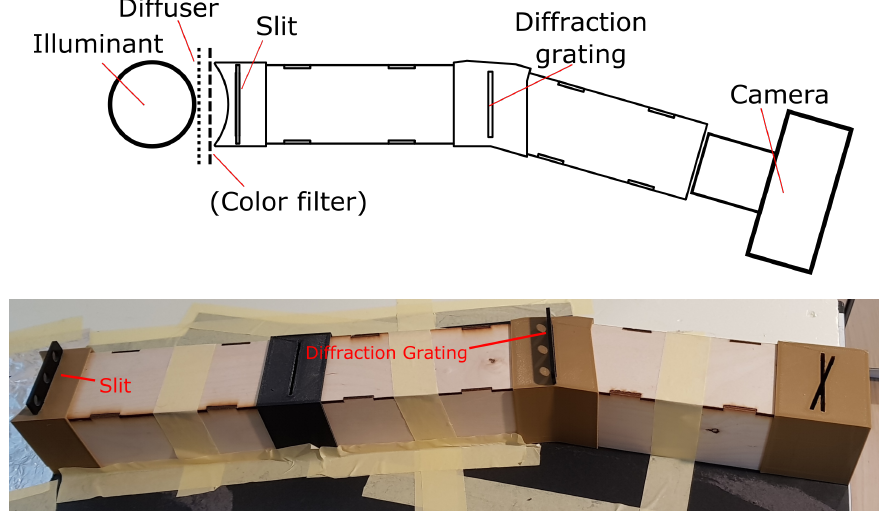
Figure 1. Overhead schematic (top; not to scale) and photo (bottom) of the imaging setup consisting (from left to right) of the illuminant, diffuser, an optional color filter, narrow slit, an enclosure, diffraction grating, an enclosure and the camera system being measured. The photo shows only the enclosed equipment, omitting the illuminant, the diffuser and the camera.